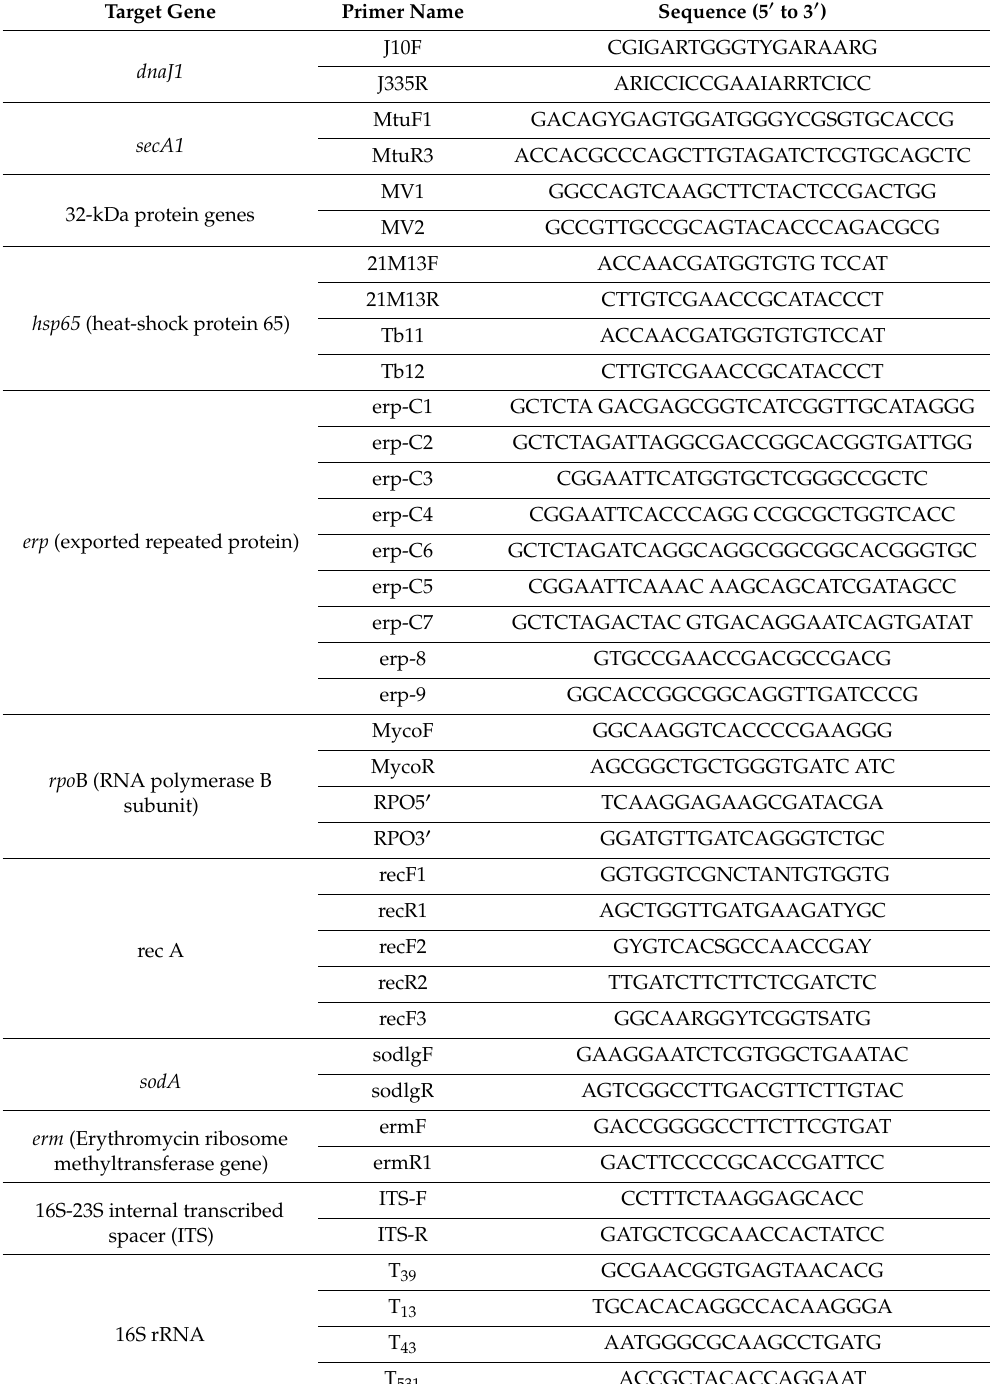
Table 3. PCR primers used for the identification Mycobacterium spp